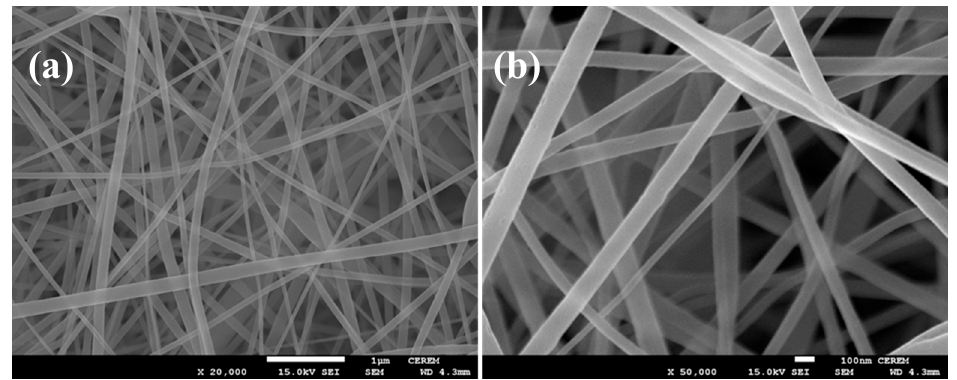
Figure 4. SEM images of the as-spun PAN/TTIP nanofibers before calcinations ( a ) 20 k; and ( b ) 50 k magnification.